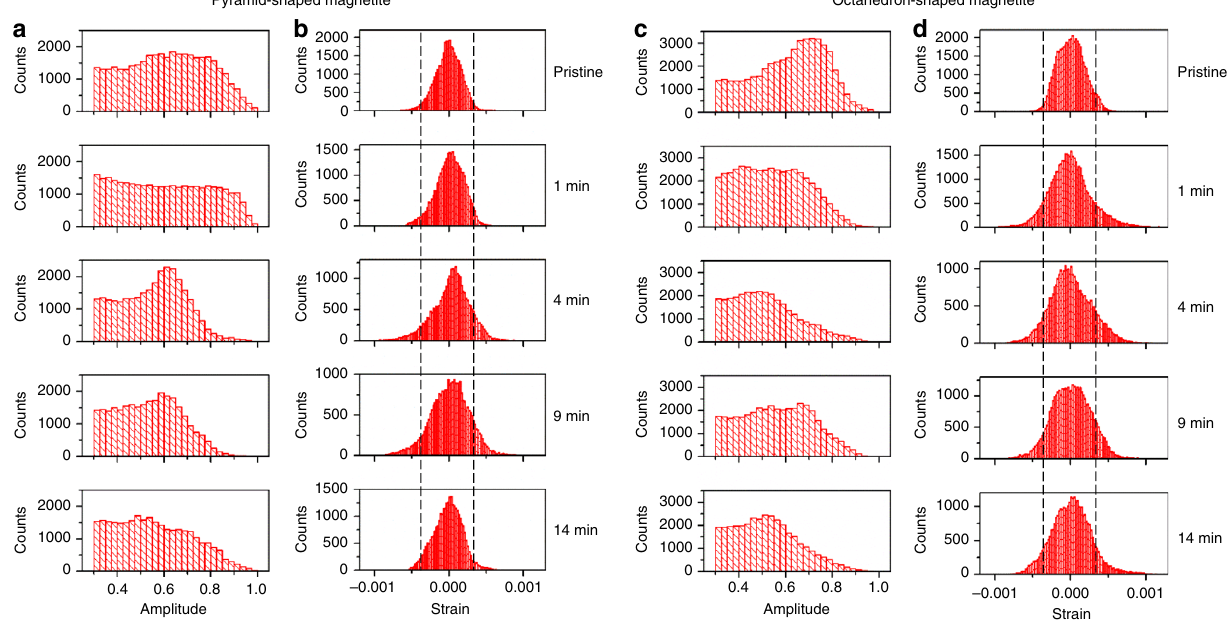
Fig. 3 Statistical distribution of amplitude and strain of the pyramid- and octahedron-shaped magnetite crystals from Figs. 1 and 2. The amplitude distributions between 0.3 and 1.0 are plotted in a , c with corresponding strain ( b , d ) distributions. Lines on the strain plots indicate the threshold values ( − 0.00035 and 0.00035) used for plotting the 3D high strain structures shown in Figs 1c and